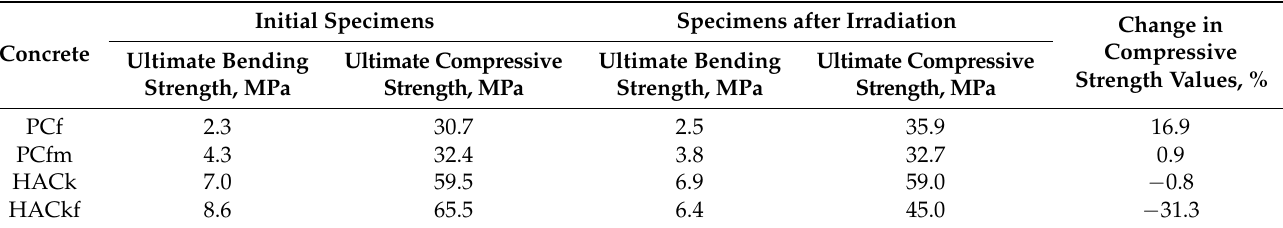
Table 2. Strength characteristics of initial and irradiated concrete specimens.